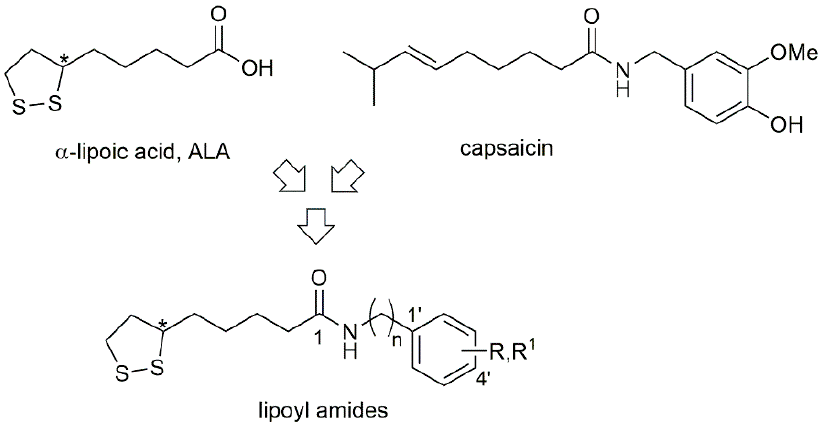
Figure 1. ALA, capsaicin and general structure of final lipoic amides.